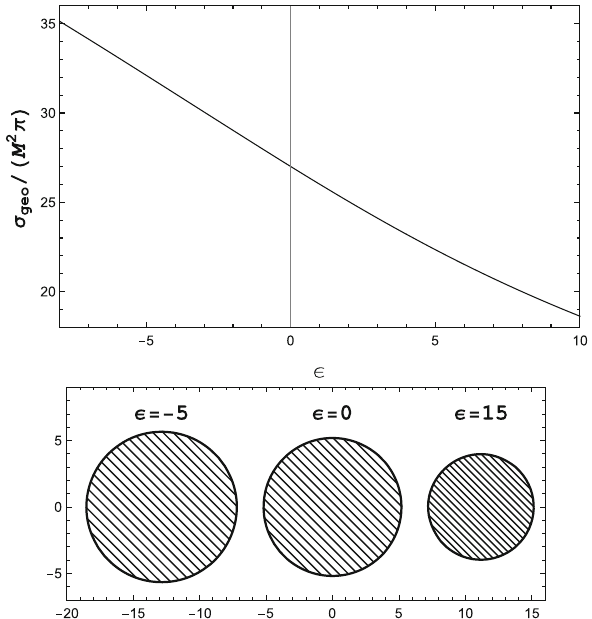
Fig. 6 Top: classical absorption cross section, as a function of ε . Bot- tom:geometricalrepresentationoftheclassicalabsorptioncrosssection for different choices of ε